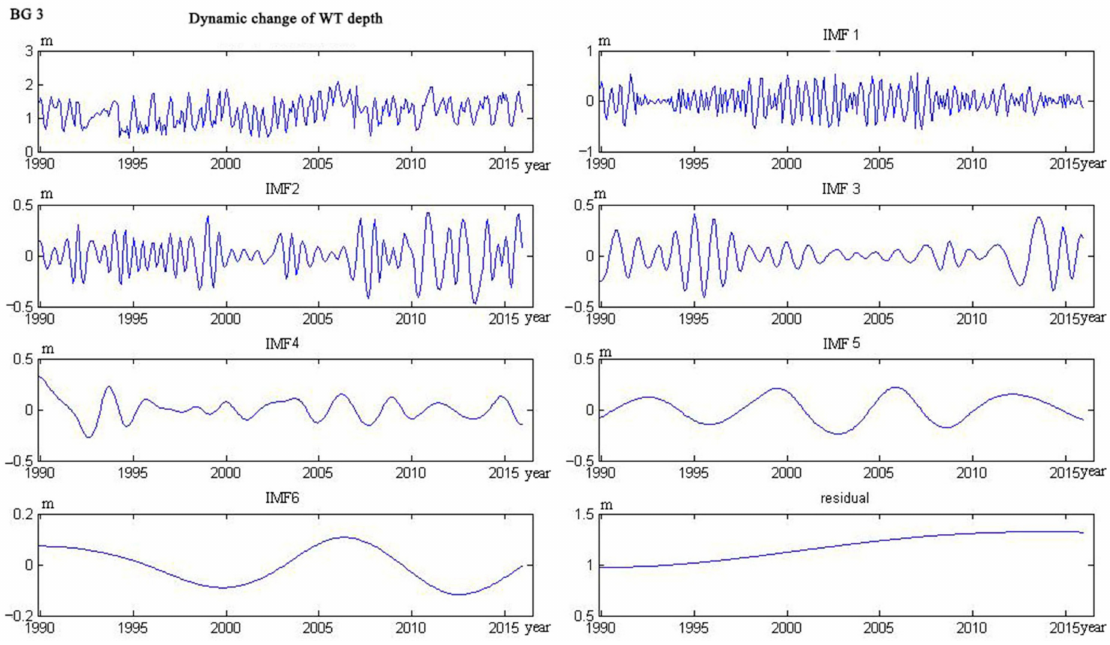
Figure A3. Decomposition of groundwater time series data of well BG3.